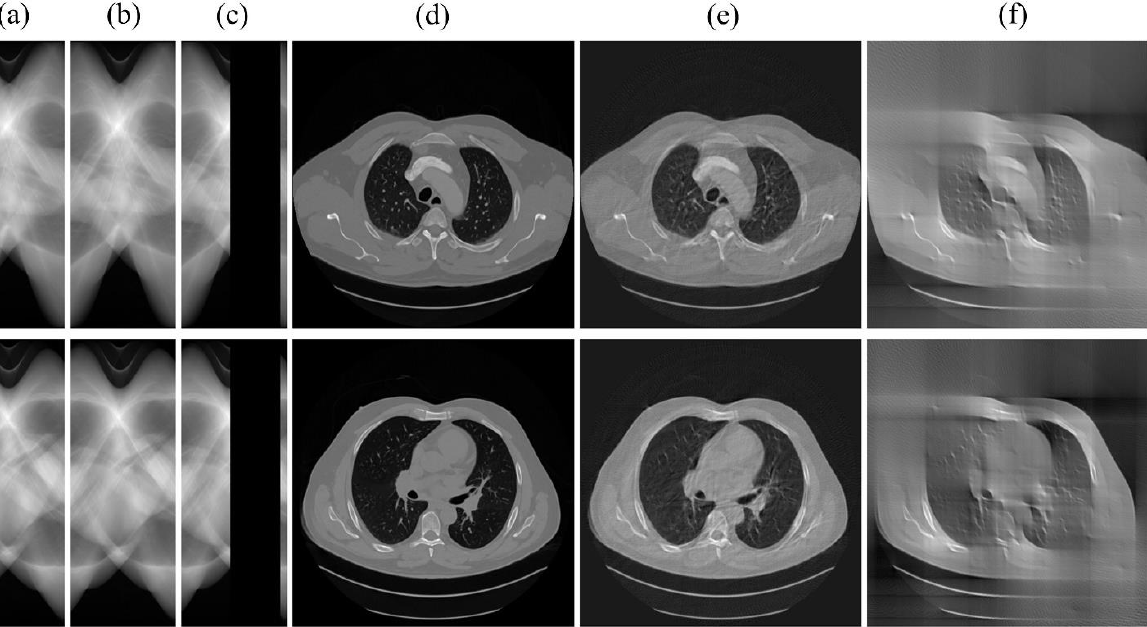
Figure 5. SI-GAN inpainting results with 90 ◦ limited-angle data (one case per row). ( a ) The ground truth of sinogram; ( b ) the output of SI-GAN with ( c ) as input; ( c ) the original 90 ◦ limited-angle data; ( d ) the ground truth of reconstruction image; ( e ) FBP reconstruction for ( b ); ( f ) FBP reconstruction for ( c